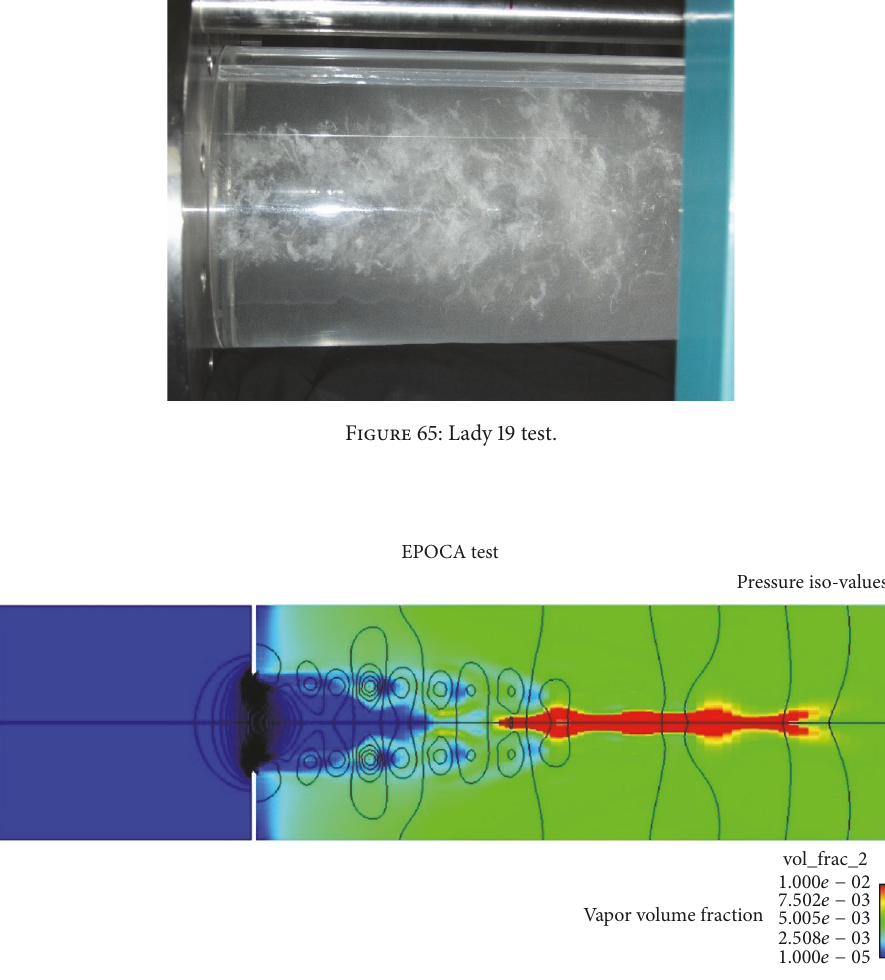
Figure 66: Lady 19 test: two-dimensional representation of the pressure and void fraction calculated by the CFD code.